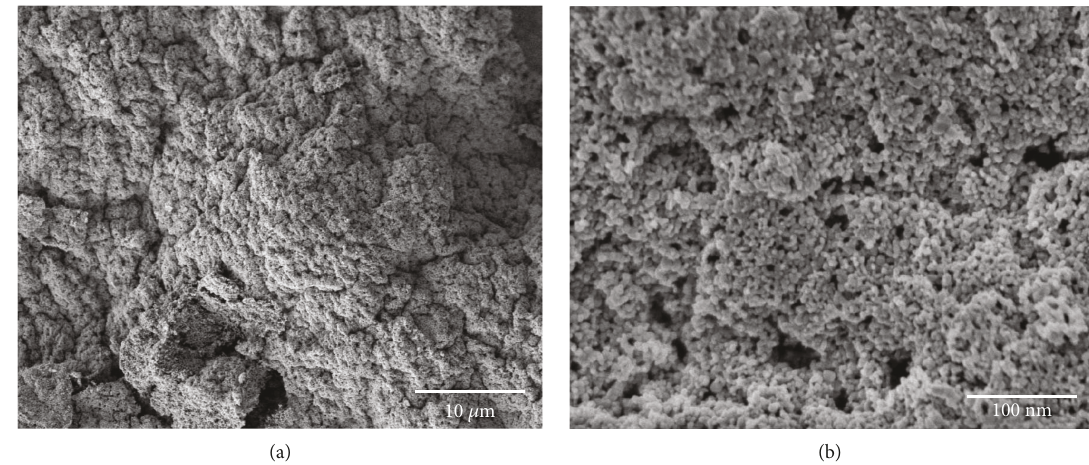
Figure 2: SEM pictures of the prepared TiO 100nm for the high-magni fi cation image